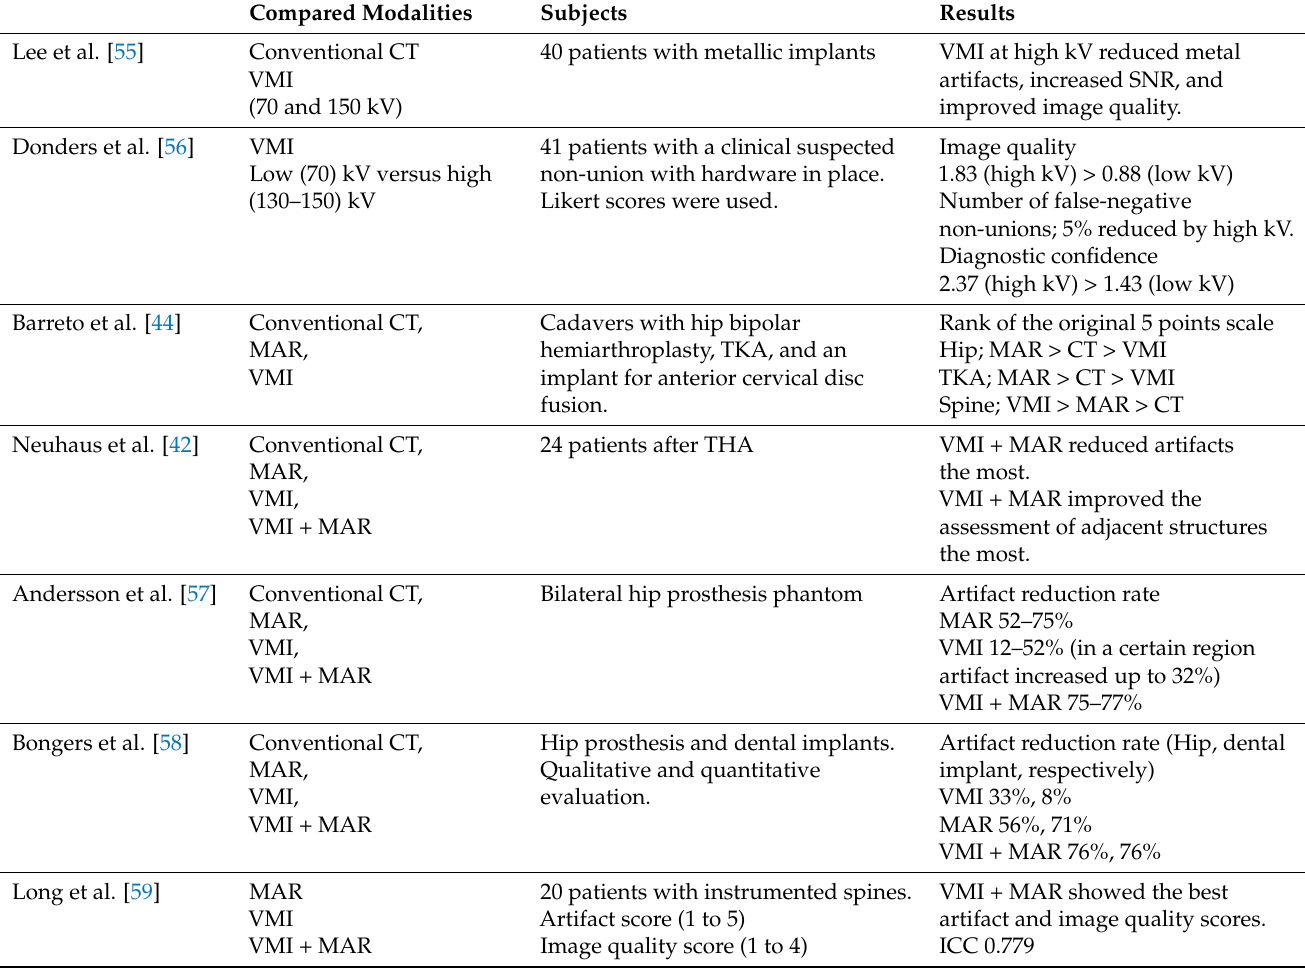
Table 2. Overview of representative CT studies. Major results are presented. AUC value was